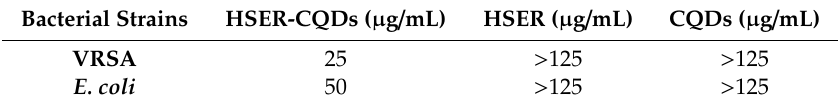
Table 1. Determining the Minimum Inhibitory Concentration (MICs) of HSER-CQD by broth micro-dilution